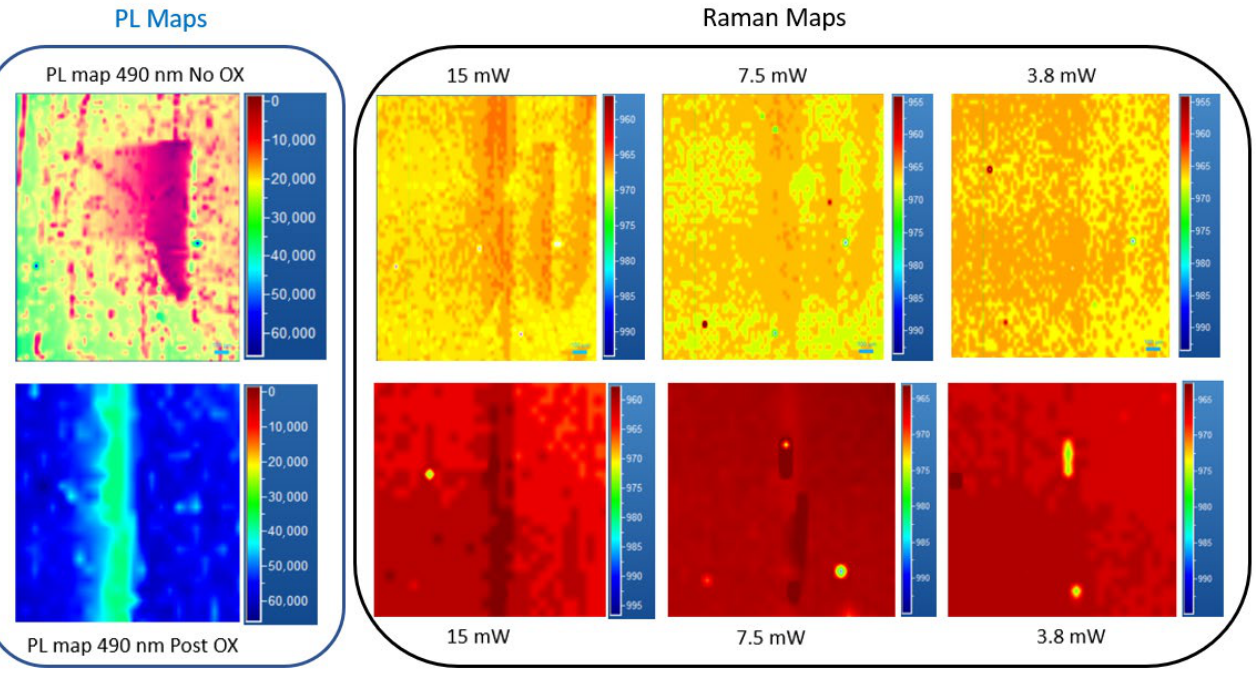
( b ) Figure 8. Carrier lifetime as a function of carrier induced. Comparison between SF-free area and defective zone ( a ); comparison between the same defects (430–490 nm) before and after oxidation process ( b ). From these results, it is evident that the oxidation process leads to an improvement in the carrier lifetime. Moreover, not all the stacking fault defects undergo the same im- provement. Considering the lifetime, the 490 nm defect is much more influenced by the oxidation process than the 430 nm. In fact, the 490 nm SF shows a large increase in the carrier lifetime at induced carriers of about 4 × 10 17 /cm −3 after the oxidation process; before this process, the increase in carrier lifetime is around 1.5 × 10 17 /cm 3 (Figure 8b). Instead, in the case of the 430 nm SF, the increase in the carrier lifetime remains the same, at the same induced carrier conditions.